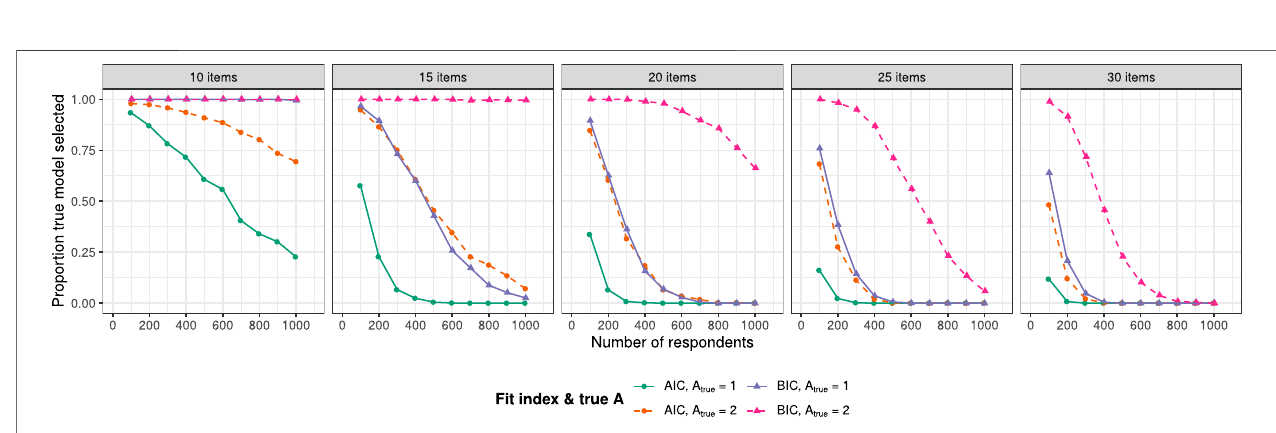
FIGURE 7 | Proportion of replications where AIC and BIC preferred the true model over the too fi ne-grained model. Results are displayed for the conditions with A true = 1 and A est = 1, 2, and with A true = 2 and A est = 2,